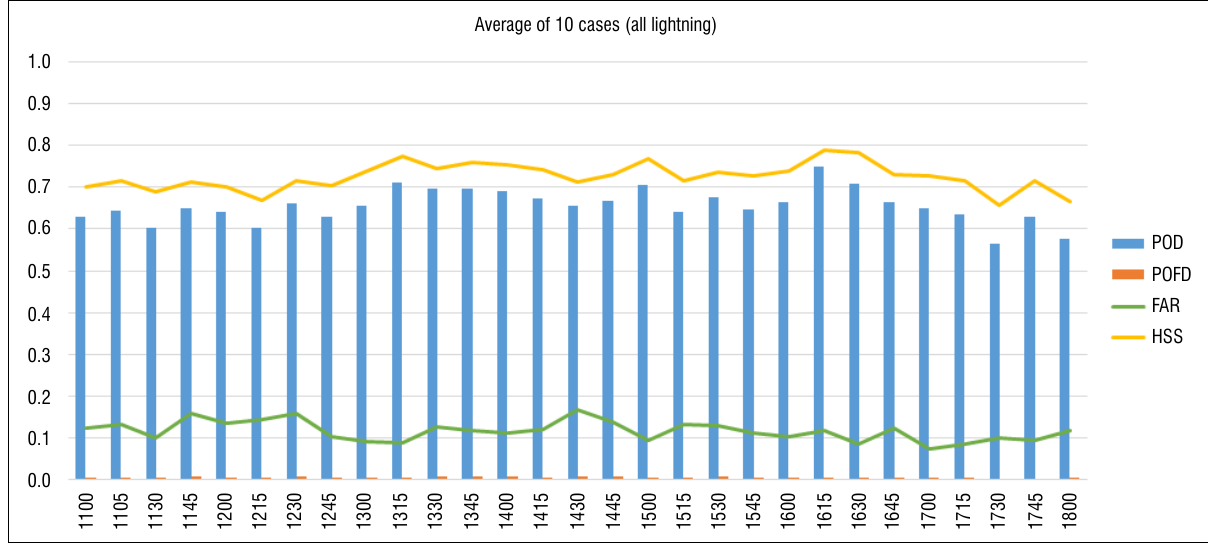
Figure 6: Probability of detection (POD, blue), probability of false detection (POFD, orange), false alarm rate (FAR, green) and Heidke skill score (HSS, yellow) for the validation of the growing and mature RDT polygons against the lightning occurrence from 11:00 to 18:00 UTC for all 10 cases.